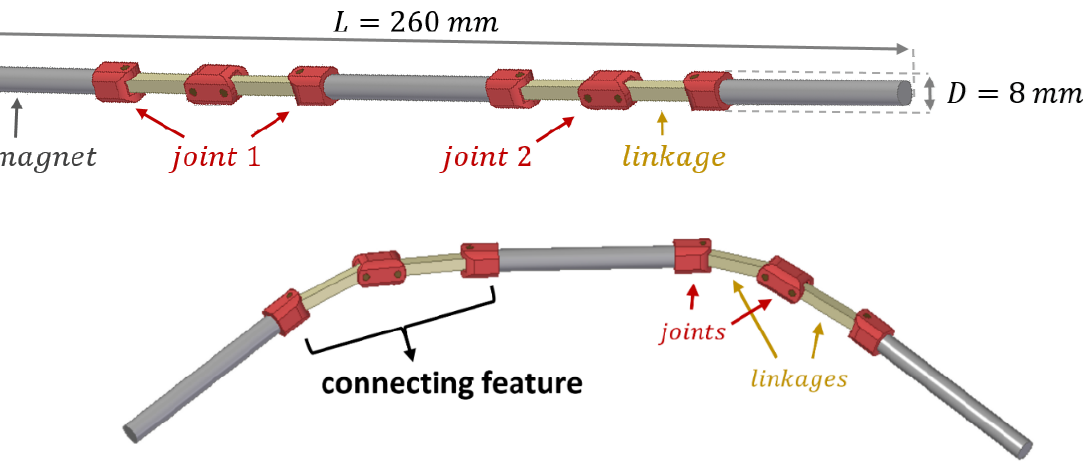
Figure 18. CAD model assembly of the detailed magnetic anchoring structure with isometric view of the CAD assembly; and some of the joints slightly bent to illustrate potential shape upon application. The device has a length of 26 cm and a maximum diameter of 8 mm. An isometric view of the device with a given bend of the connecting feature with some of the joints slightly rotated is illustrated in Figure 18.